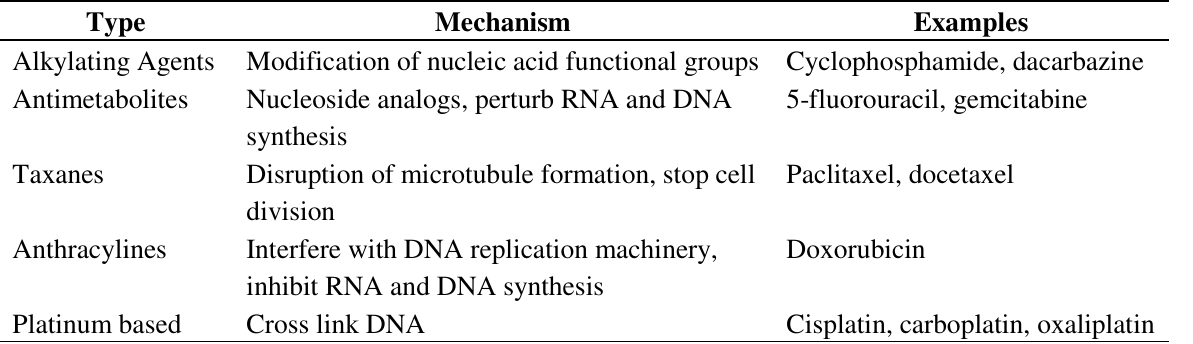
Table 1. Common chemotherapy agents and their classification (adapted from